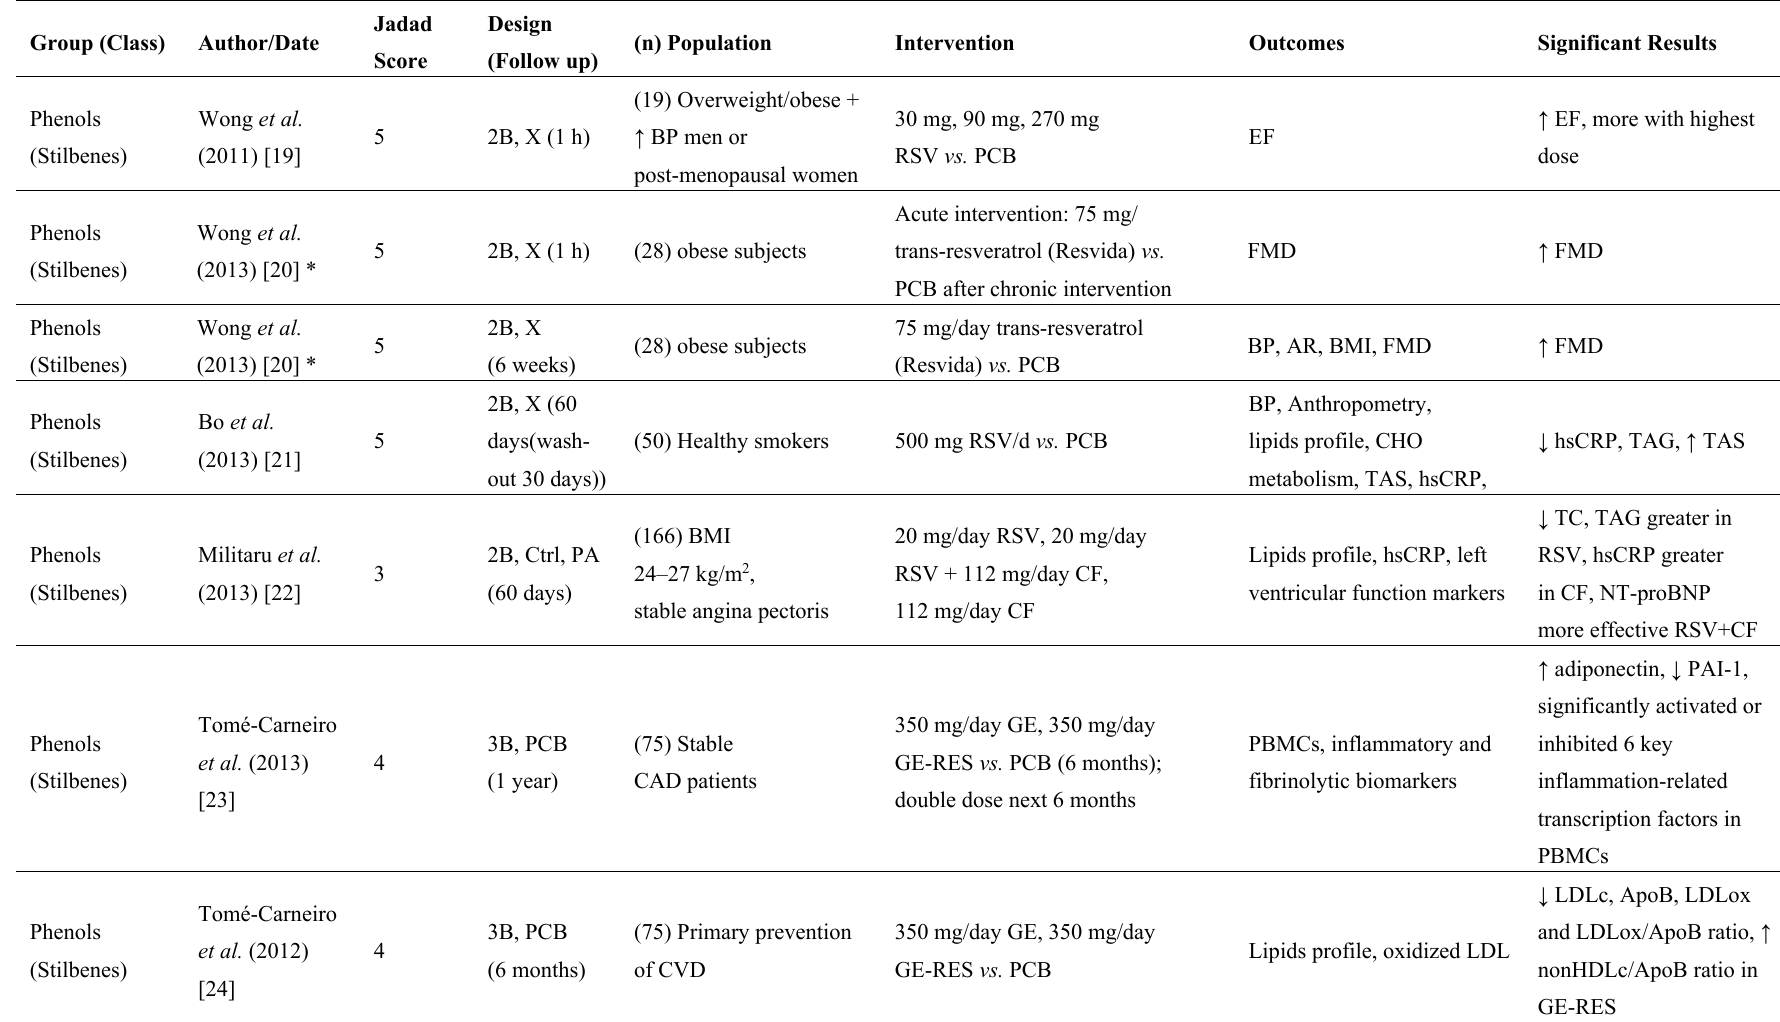
Table 1. RCTs of phenolic compounds (catechols, stilbenes and beer/wine) in CVD